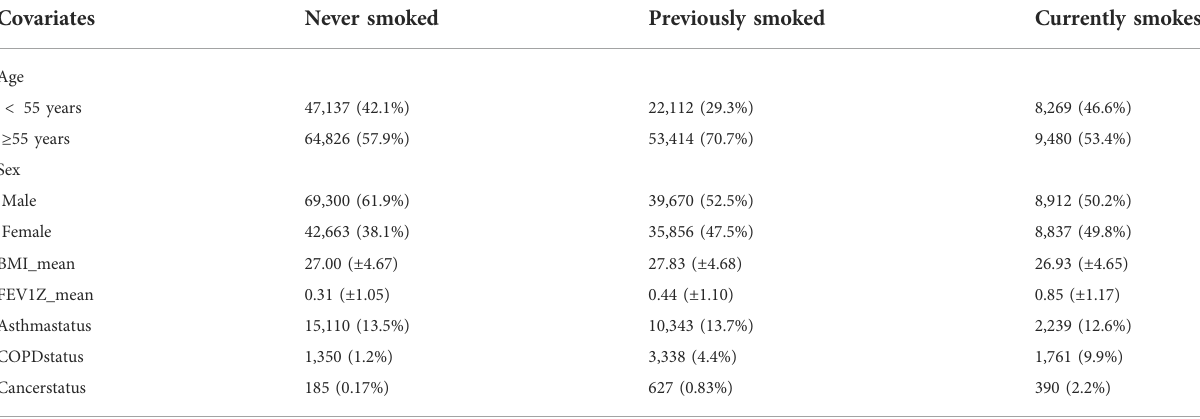
TABLE 1 Descriptive statistics of the dataset. This table givesthe relationships between smoking status and other covariates,i.e., age, sex, BMI,FEV1Z score, asthma status, COPD status, and lung cancer status. Covariates Never smoked Previously smoked Currently